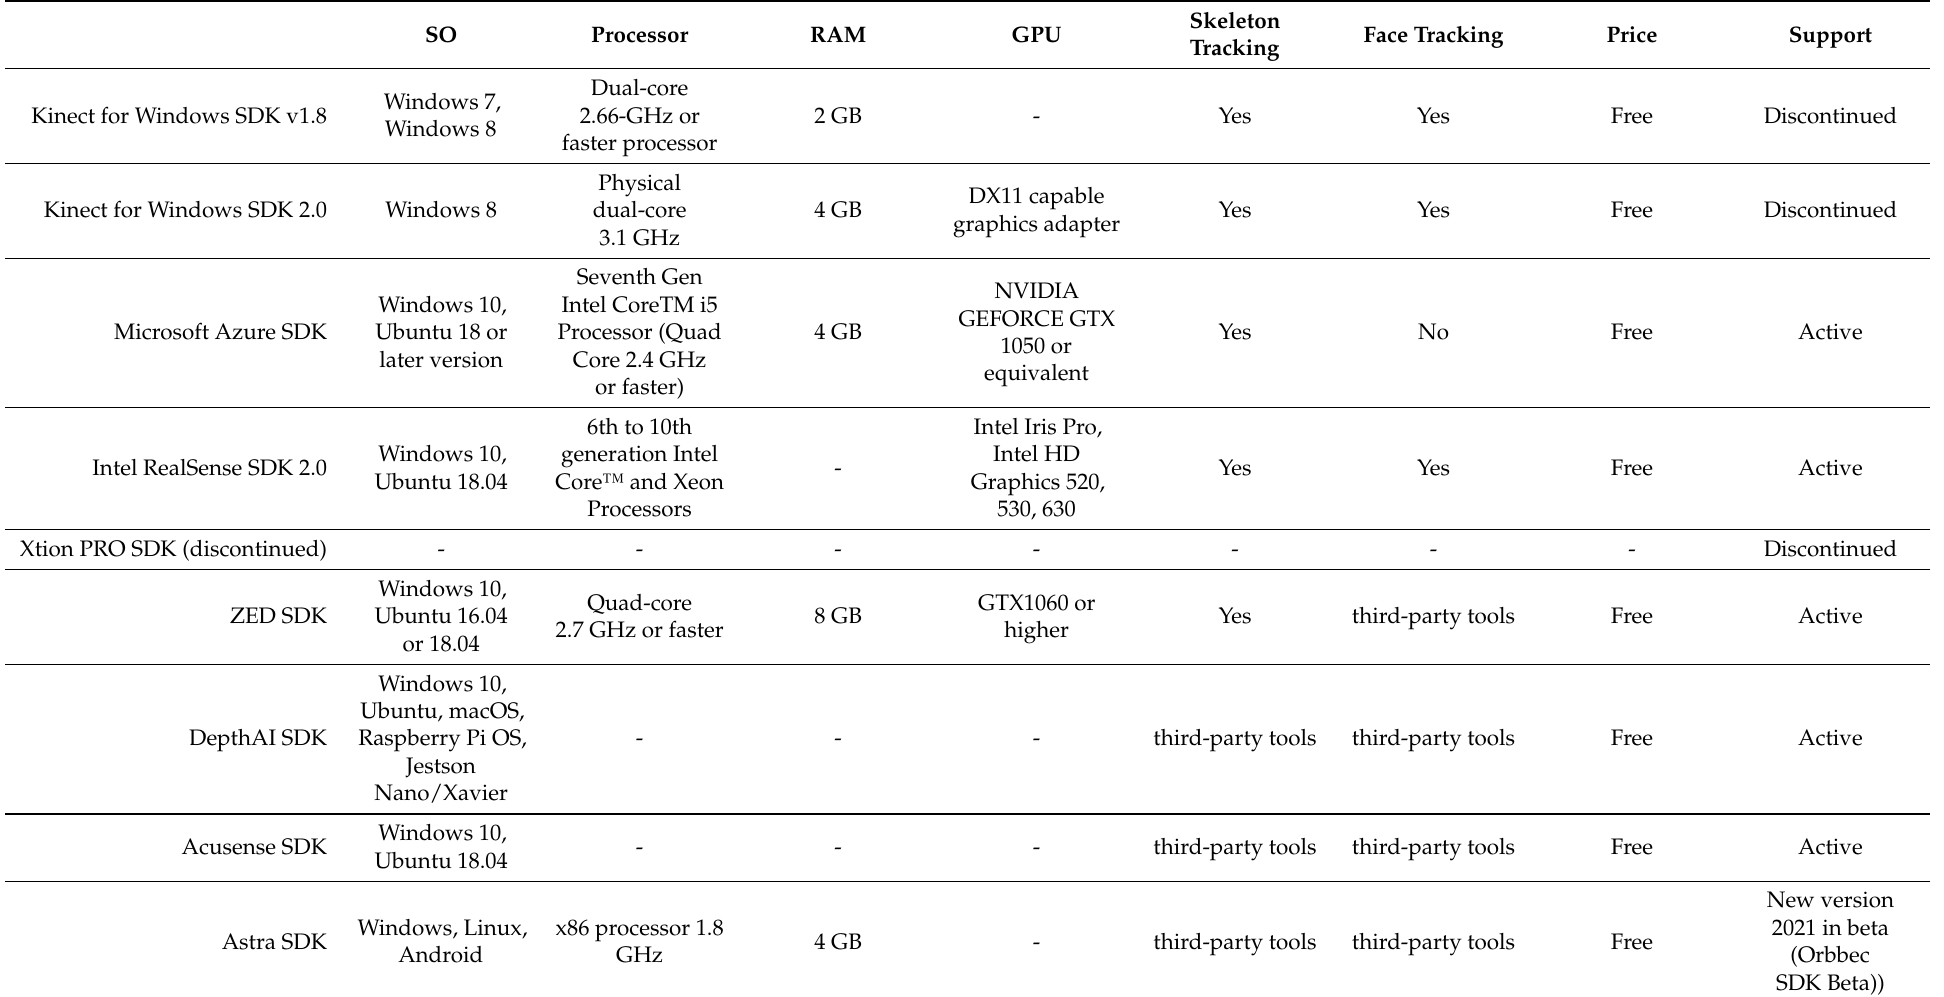
Skeleton Face Tracking Price Support Tracking